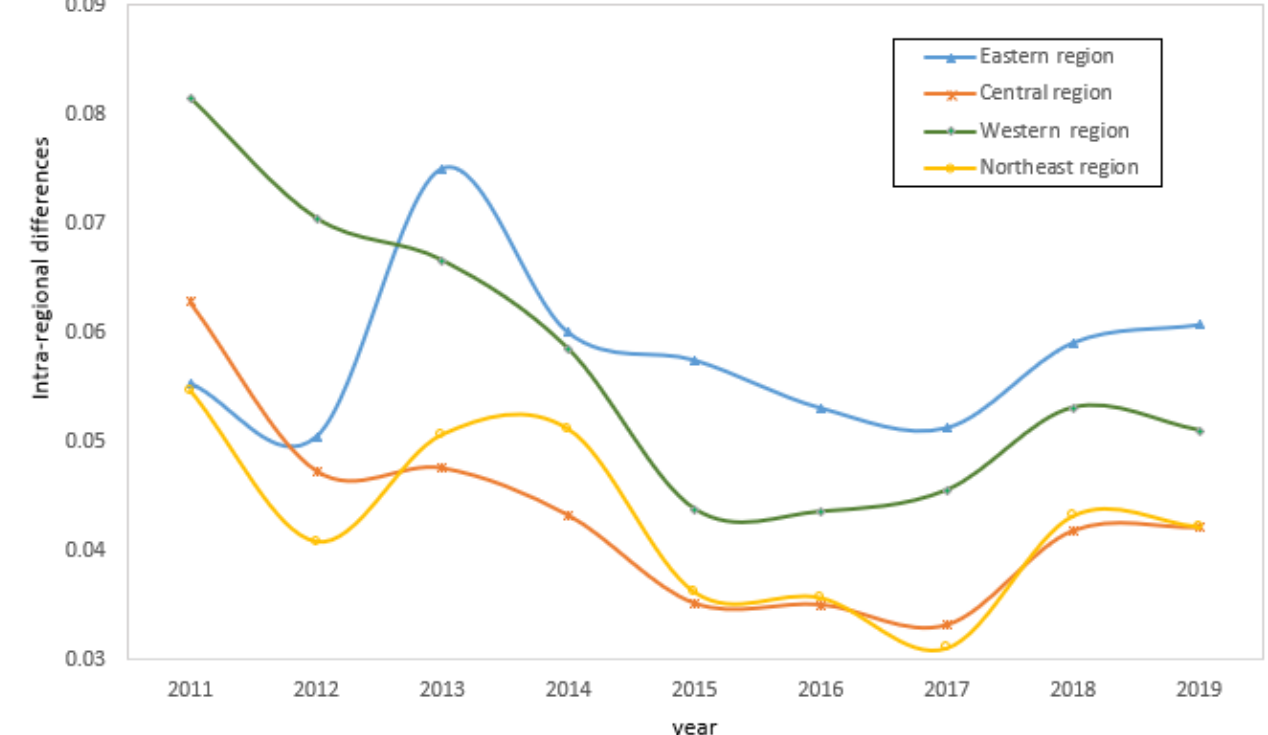
Figure 5. Gini coefficient of CD&GDD within four economic zones from 2011 to 2019.